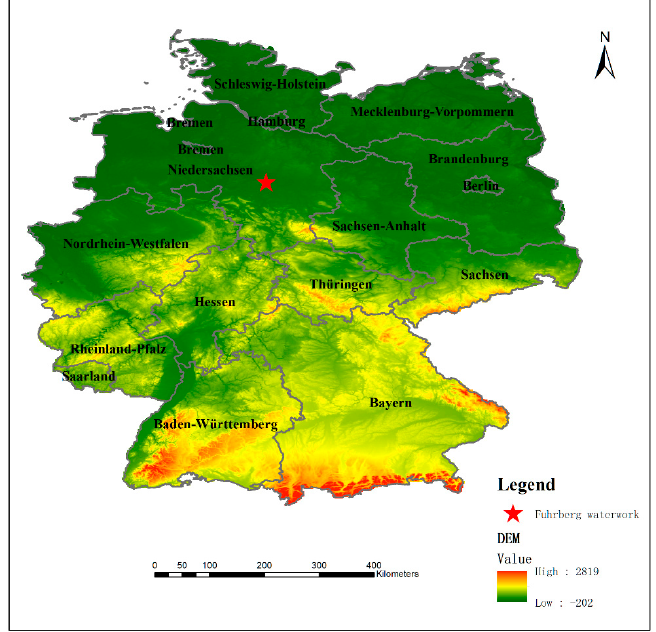
Figure 1. Location of the Fuhrberg waterworks.